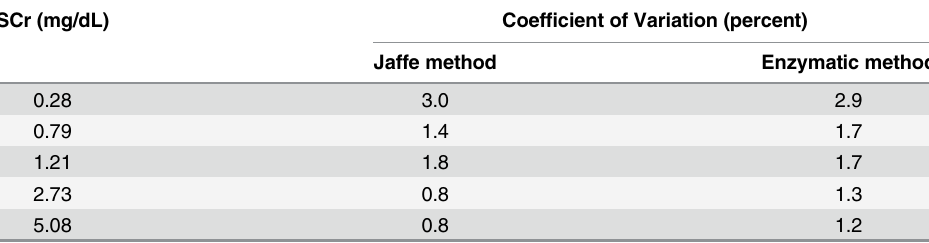
Table 1. Comparison of precision of the Jaffe and enzymatic methods for serum creatinine (SCr).